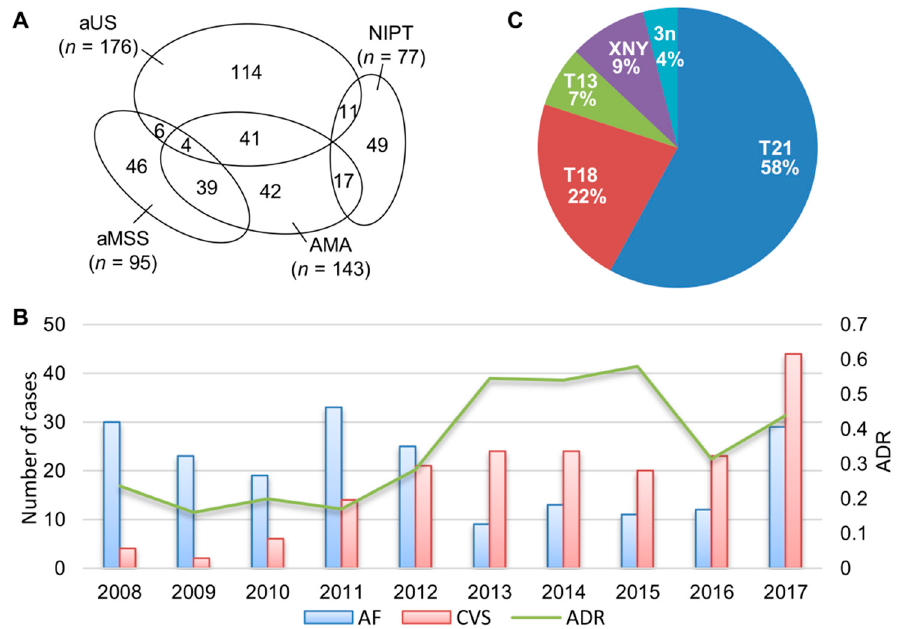
Figure 1. Laboratory annual caseload and common aneuploidies detected. ( A ) The number of prenatal cases with single and overlapping clinical indications of abnormal ultrasound findings (aUS), advanced maternal age (AMA), abnormal maternal serum screening (aMSS), and non-invasive prenatal testing (NIPT). ( B ) Annual caseload and abnormality detection rate (ADR) for common aneuploidies from aneuvysion fluorescence in situ hybridization (FISH) and chromosome analyses on amniotic fluid (AF) and chorionic villus sampling (CVS) cases ( C ) A pie chart shows relative frequencies for trisomy 21 (T21), trisomy 18 (T18), trisomy 13 (T13), sex chromosome aneuploidies (XNY/X), and triploidy (3n).